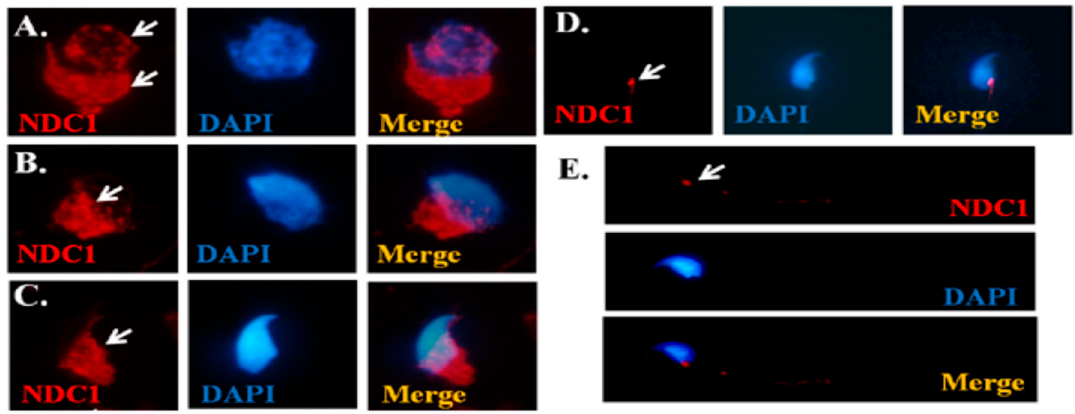
Figure 2. Localization of NDC1 during murine spermiogenesis. Immunofluorescence assay (IFA) results revealed multiple localizations of NDC1 signals: ( A ) round spermatids; ( B , C ) elongating spermatids; ( D ) elongated spermatids; and ( E ) mature spermatozoa. Anti-NDC1 antibody (“NDCI” panels), DAPI antibody (“DAPI” panels), and a combination of anti-NDC1 and DAPI antibodies (“Merge” panels) were used as stains. The arrows indicate NDC1 signals. NDC1: red; DAPI: blue. Magnification = 1000×.